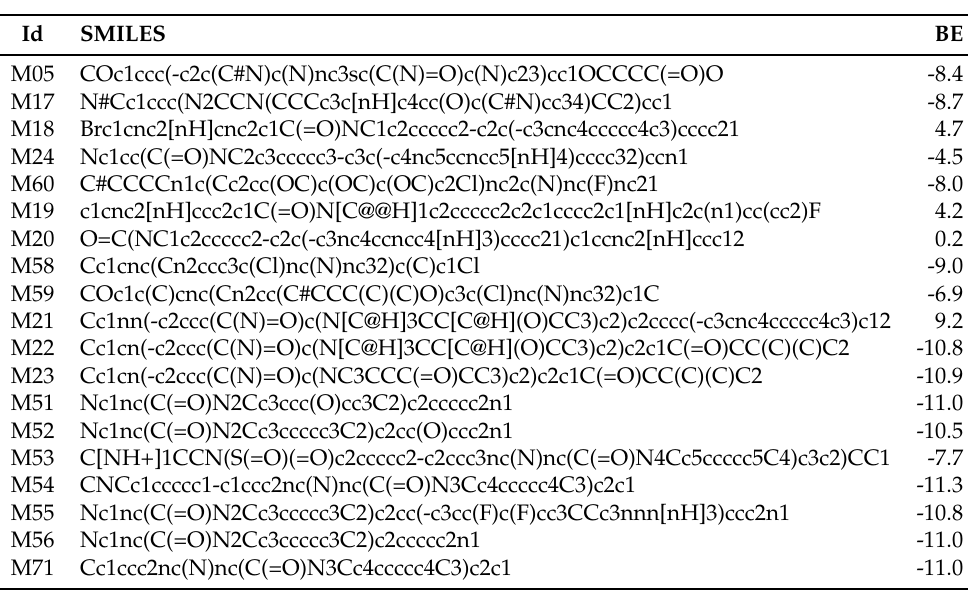
Table 3. Hsp90 inhibitors: “others”